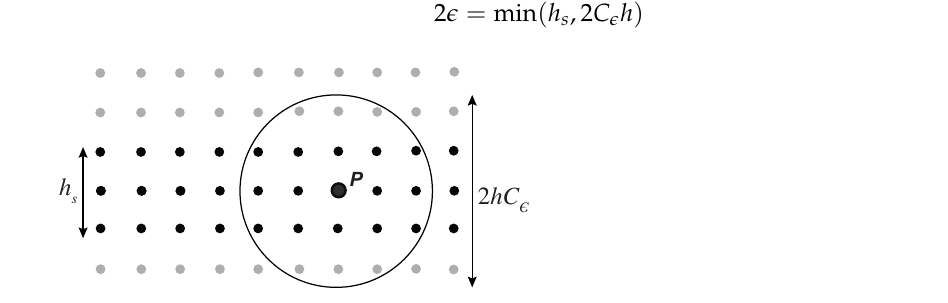
Figure 4. Scheme of the measurements of the soft layer (black dots) and the (cid:101) -neighborhood around material point